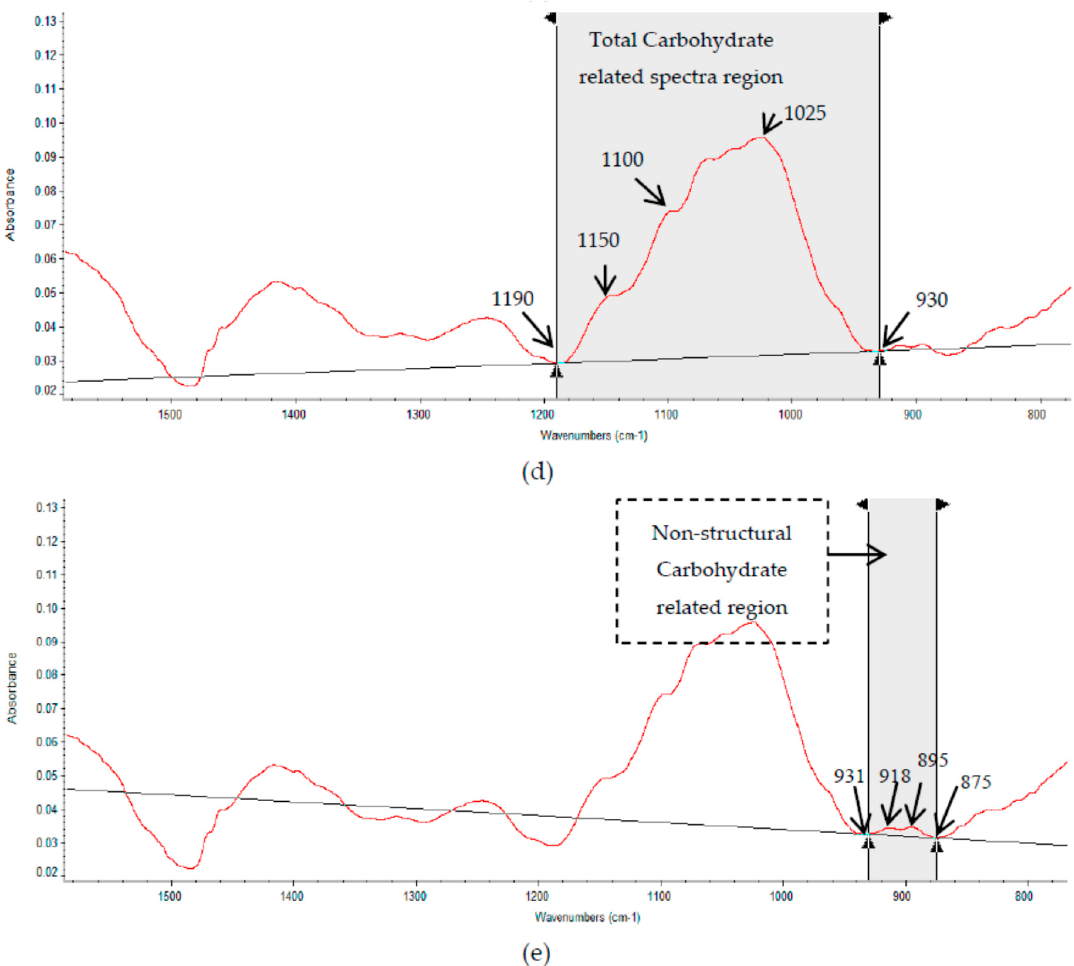
Figure 2. Typical ATR/FTIR molecular spectral for alfalfa: ( a ) whole mid-IR spectrum region ( ca. 4000–800 cm − 1 ); ( b ) structural carbohydrate related spectrum region ( ca . 1485–1188 cm − 1 ); ( c ) cellulosic compound related spectrum region ( ca . 1294–1188 cm − 1 ); ( d ) total carbohydrate related spectrum region ( ca . 1190–930 cm − 1 ); ( e ) non-structural carbohydrate related spectrum region ( ca . 931–875 cm − 1 ).